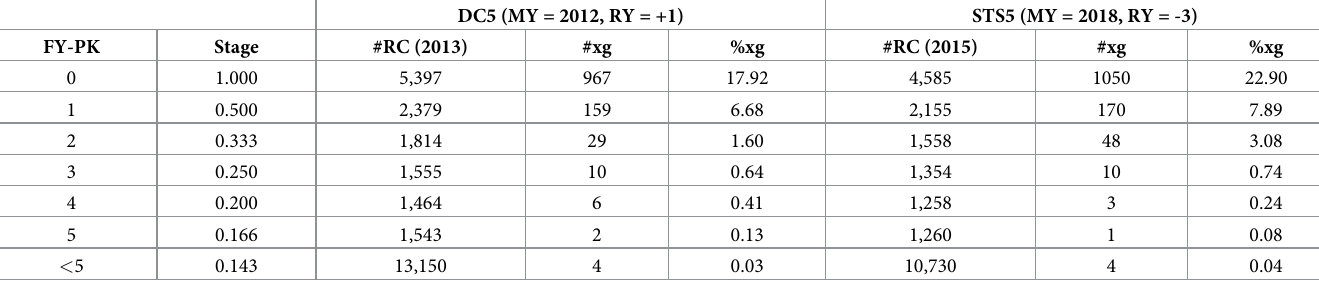
Table 3. Likelihood of exceptional growth (xg) by stage using RCs with at least 20 papers in the FY.